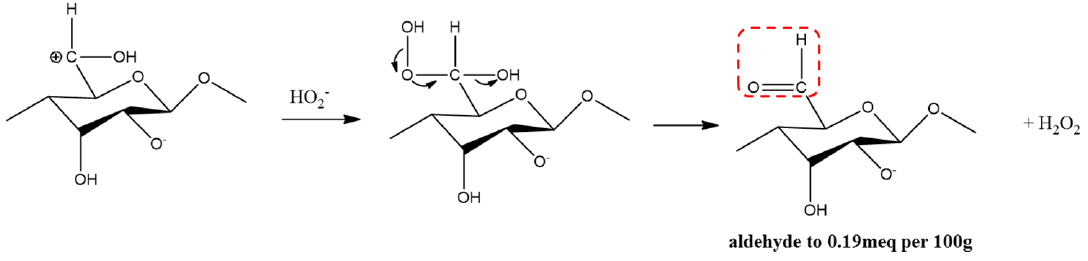
Figure 7. Oxidation of cellulose by hydroperoxyl radicals.